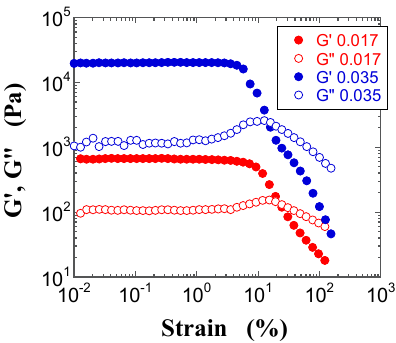
Figure 8. Double-logarithmic plots of the storage modulus ( G ′ , filled circles) and the loss modulus ( G" , open squares) for the FS suspensions at φ = 0.017 (red) and 0.035 (blue) as a function of strain.